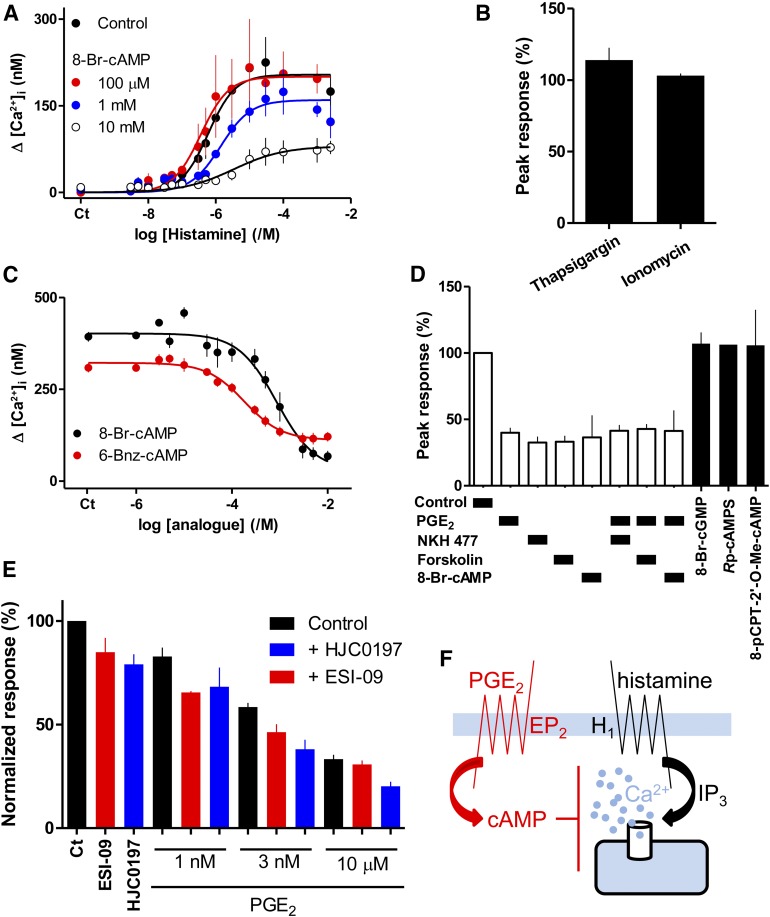
Cyclic AMP mediates inhibition of histamine-evoked Ca2+ signals by PGE2. (A) Effect of 8-Br-cAMP (added 20 minutes before histamine) on the peak Ca2+ signals evoked by the indicated concentrations of histamine. Results are means ± S.E.M. from at least three experiments with one to three wells in each. (B) 8-Br-cAMP (10 mM, 20 minutes) had no effect on the Ca2+ content of the intracellular stores as revealed by the increases in [Ca2+]i evoked by addition of thapsigargin (1 μM) or ionomycin (1 μΜ) in Ca2+-free HBS. Results (percentages of responses without 8-Br-cAMP) are means ± S.E.M. from five experiments with three to four wells analyzed in each. (C) Effect of the indicated cyclic nucleotides (added 20 minutes before histamine) on the peak Ca2+ signals evoked by histamine (3 μM). Results are means ± S.E.M. from three to five experiments with two to three wells in each. (D) Effect of NKH 477 (100 μM, 5 minutes), forskolin (100 μM, 5 minutes), 8-Br-cAMP (10 mM, 20 minutes), PGE2 (10 μΜ, 5 minutes), 8-Br-cGMP (10 mM, 20 minutes), Rp-cAMPS (10 mM, 20 minutes), or 8-pCPT-2′-O-Me-cAMP (10 mM, 20 minutes) alone or in combination on the peak Ca2+ signals evoked by histamine (1 mM). Results (as percentages of the response to histamine alone) are means ± S.E.M. from three experiments with two to three wells in each. Results for Rp-cAMPS are from a single experiment with three replicates, limited by the availability of this expensive analog. (E) Effects of the EPAC antagonists, ESI-09 and HJC0197 (10 μM, 20 minutes), on the Ca2+ signals evoked by histamine (3 μM) added 5 minutes before and then during treatment with the indicated concentrations of PGE2. Results are expressed as percentages of the paired response to histamine alone (means ± S.E.M., n = 3–5; n = 2 for the antagonists with 1 and 3 nM PGE2, where error bars show ranges). (F) The results establish that cAMP mediates inhibition of histamine-evoked Ca2+ signals by PGE2.